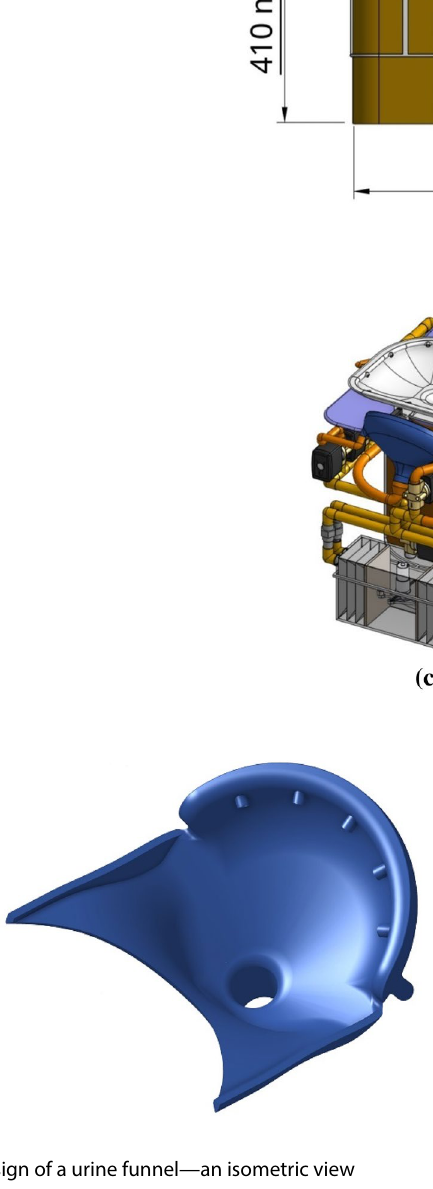
Fig. 2 Design overview and measurements of assembled parts of a WCS. a Side view with overall 590 mm length. b Front view with overall 390 mm width and 500 mm height. c General isometric view. d Top view with 400 mm length of commode seat